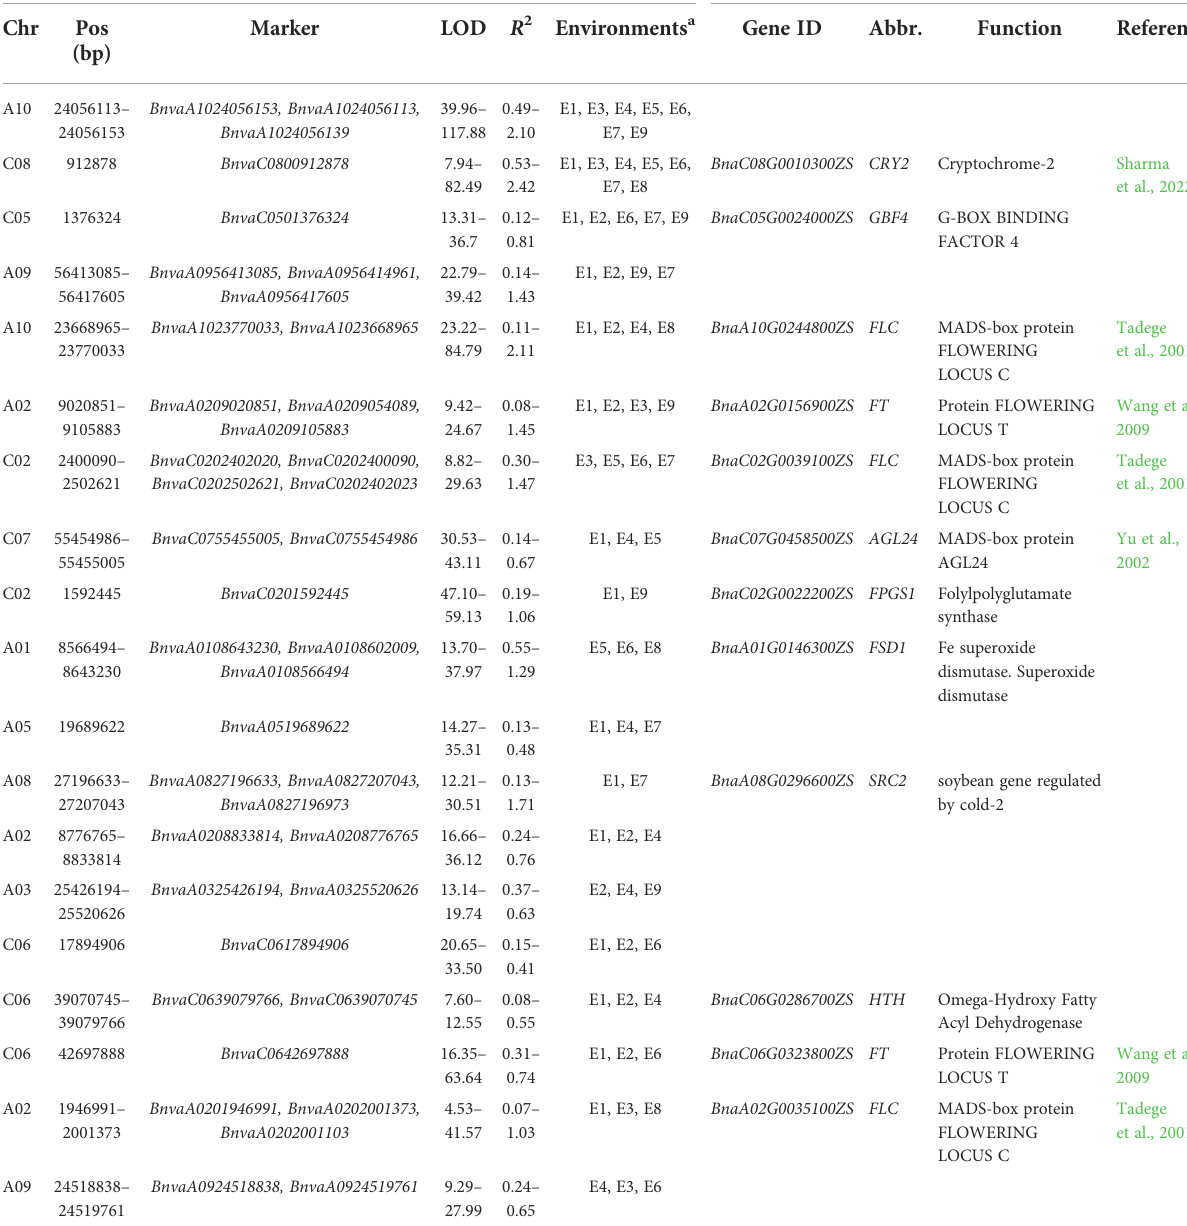
TABLE 1 Nineteen stable QTNs for B. napus fl owering time and their candidate